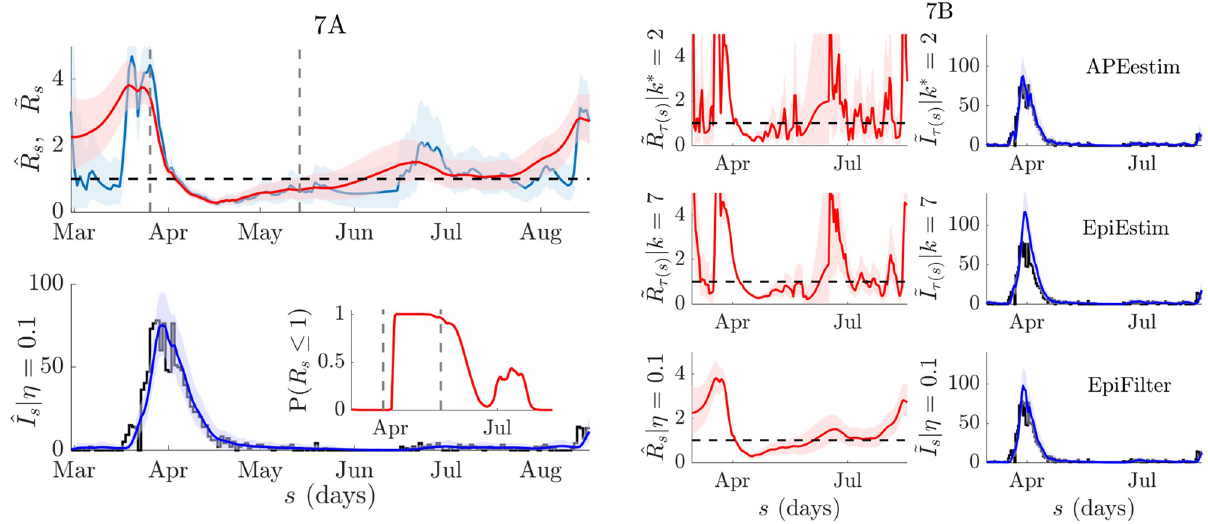
Fig 7. COVID-19 transmission in New Zealand. We compute smoothed and filtered reproduction number estimates, ^ R (red) and ~ R (blue) s s respectively, from the COVID-19 incidence curve for New Zealand (available at [43]) in the left panels. We use EpiFilter with m = 2000, η = 0.1, R min = 0.01 and R max = 10 with a uniform prior distribution over the grid R . The top of 7A shows conditional mean estimates and 95% credible intervals for ^ R s (red) and ~ R (blue). Vertical lines indicate the start and end of lockdown, a major intervention that was employed to halt transmission. The additional s ‘future’ information used in smoothing has a notable effect. The bottom of 7A provides smoothed one-step-ahead predictions ^ I (blue, with 95% s credible intervals) of the actual reported cases I (black). The inset gives the estimated probability of R � 1. We observe a clear trend of subcritical s s transmission that eventually seeds a second wave by August. In 7B we compare EpiFilter with EpiEstim (using weekly windows) and APEestim (both with Gam(1, 2) priors) with all left subfigures presenting R estimates and right ones providing filtered I predictions. We observe that both APEestim s s and EpiEstim lead to largely unusable estimates that mask transmission trends, in sharp contrast to EpiFilter.